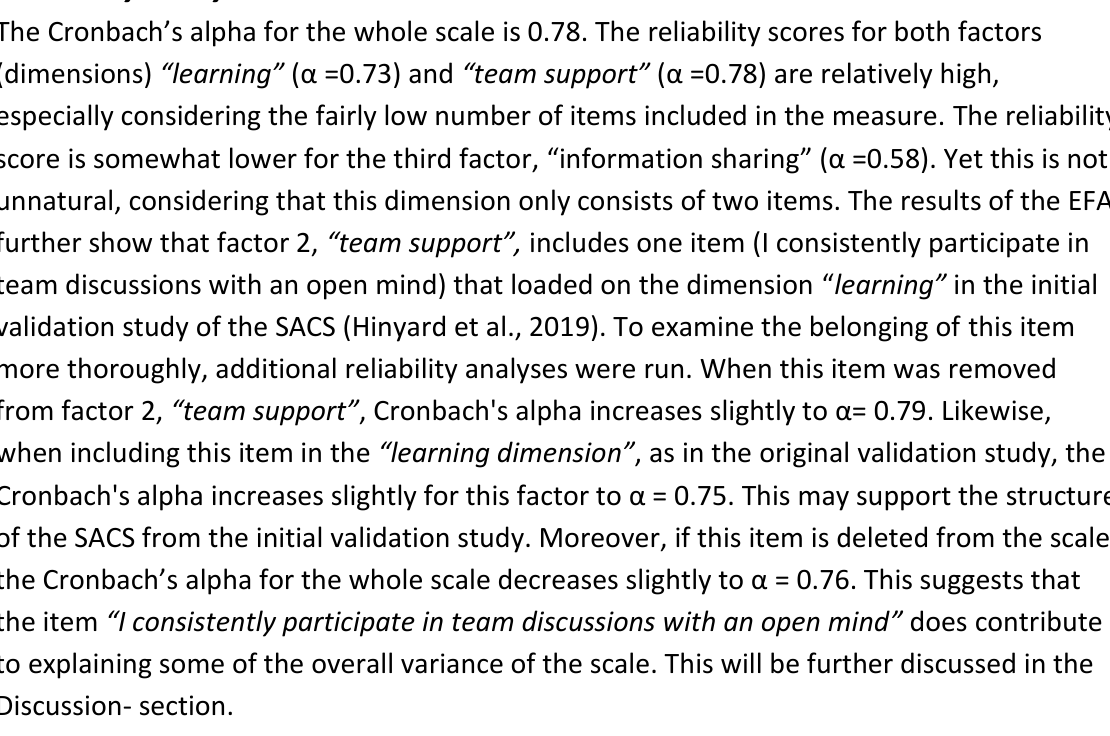
Table 5. Results of a multiple regression analysis, testing the effect of students’ background variables on their scores on the SACS measure